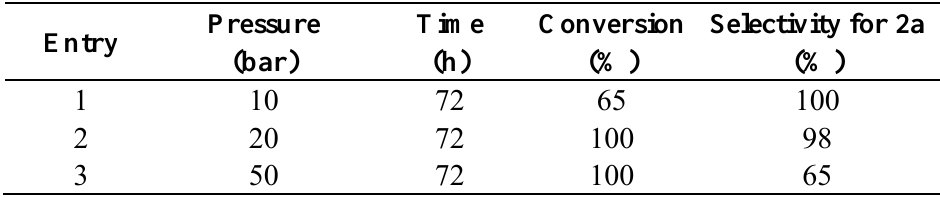
Table 2. Effect of hydrogen pressure on the hydrogenation reaction of 1a (2.12